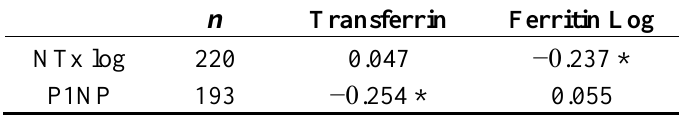
Table 5. Correlations between iron and bone remodeling biomarkers in menstruating